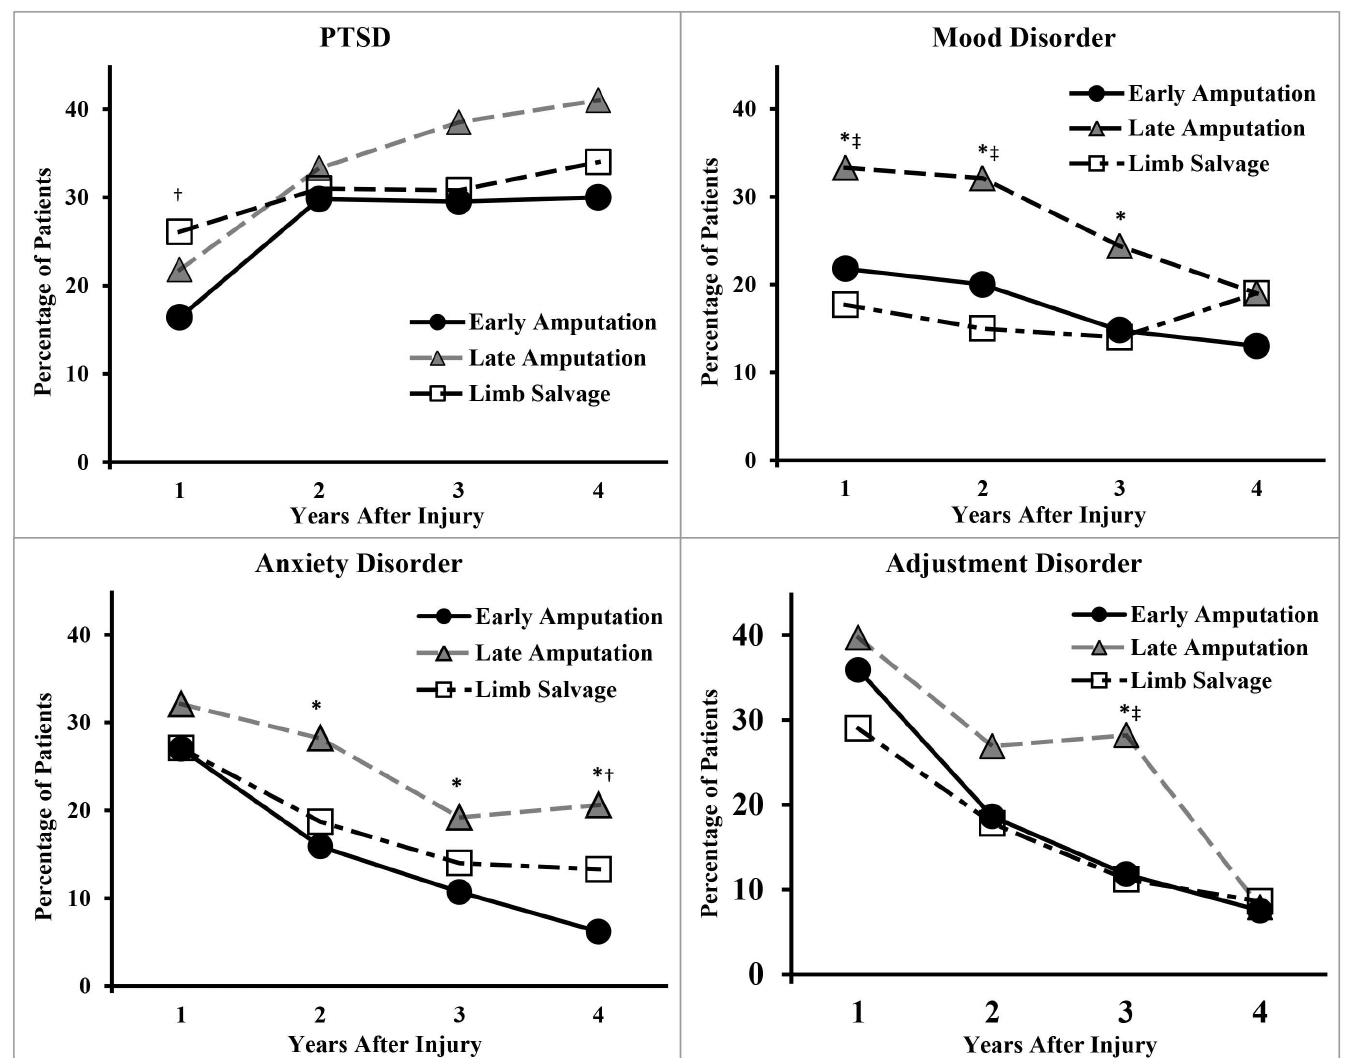
Fig 3. Prevalence of Selected Psychological Disorders by Time After Injury. Statistically significantdifference betweengroups, using chi-squareor Fisher’s exact test as appropriate, p < 0.05 were * early amputation versus late amputation, †earlyamputation versus limb salvage,and ‡late amputation versus limb salvage.(Table 4 shows where injury group was significantly associatedwith outcomes after adjustingfor covariates). PTSD = posttraumatic stress